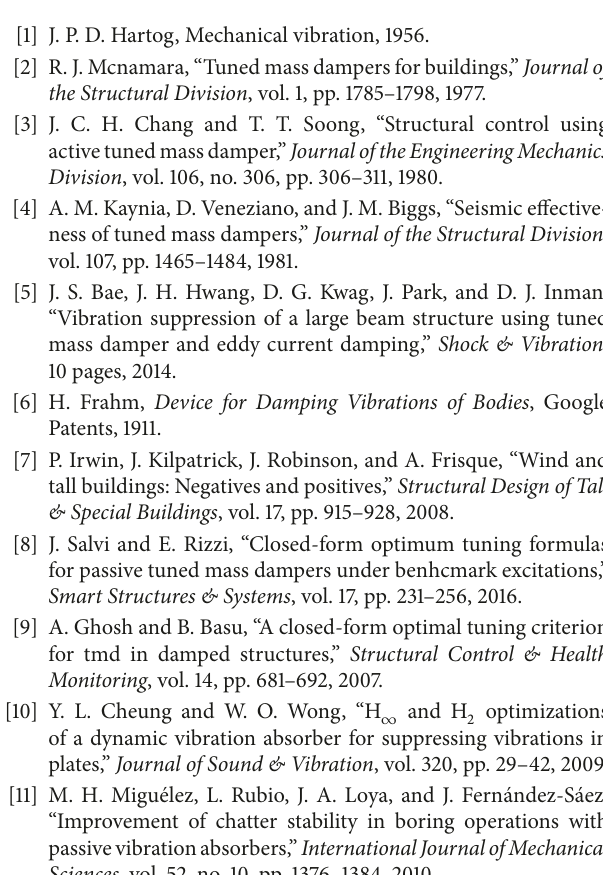
classical TMD, while, in accelerations, the relative reduction ratio is 6.95%. On the other hand, in the root mean square value of the primary structure displacement, the relative reduction is 9.71% and